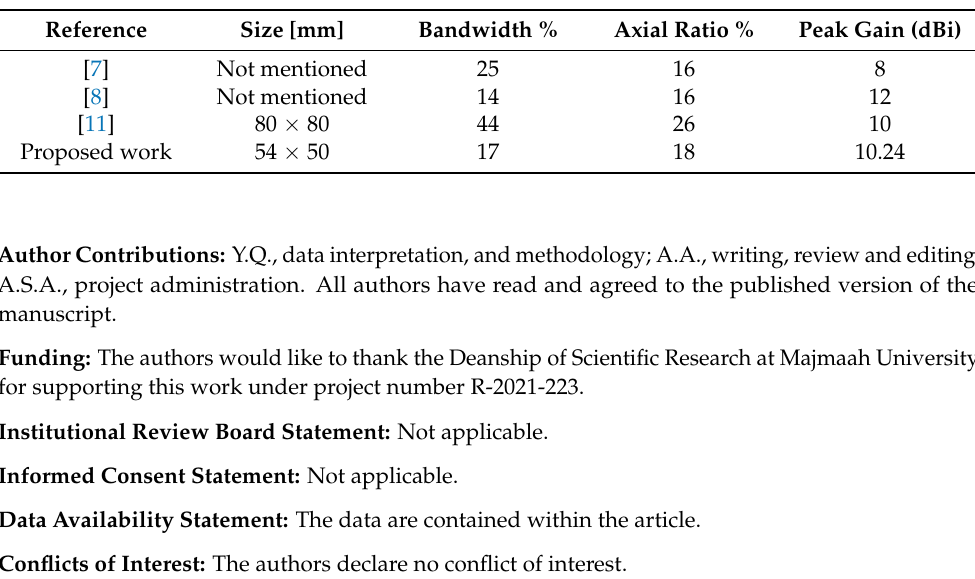
Table 2. Comparison between the proposed array and other 2 × 2 SR